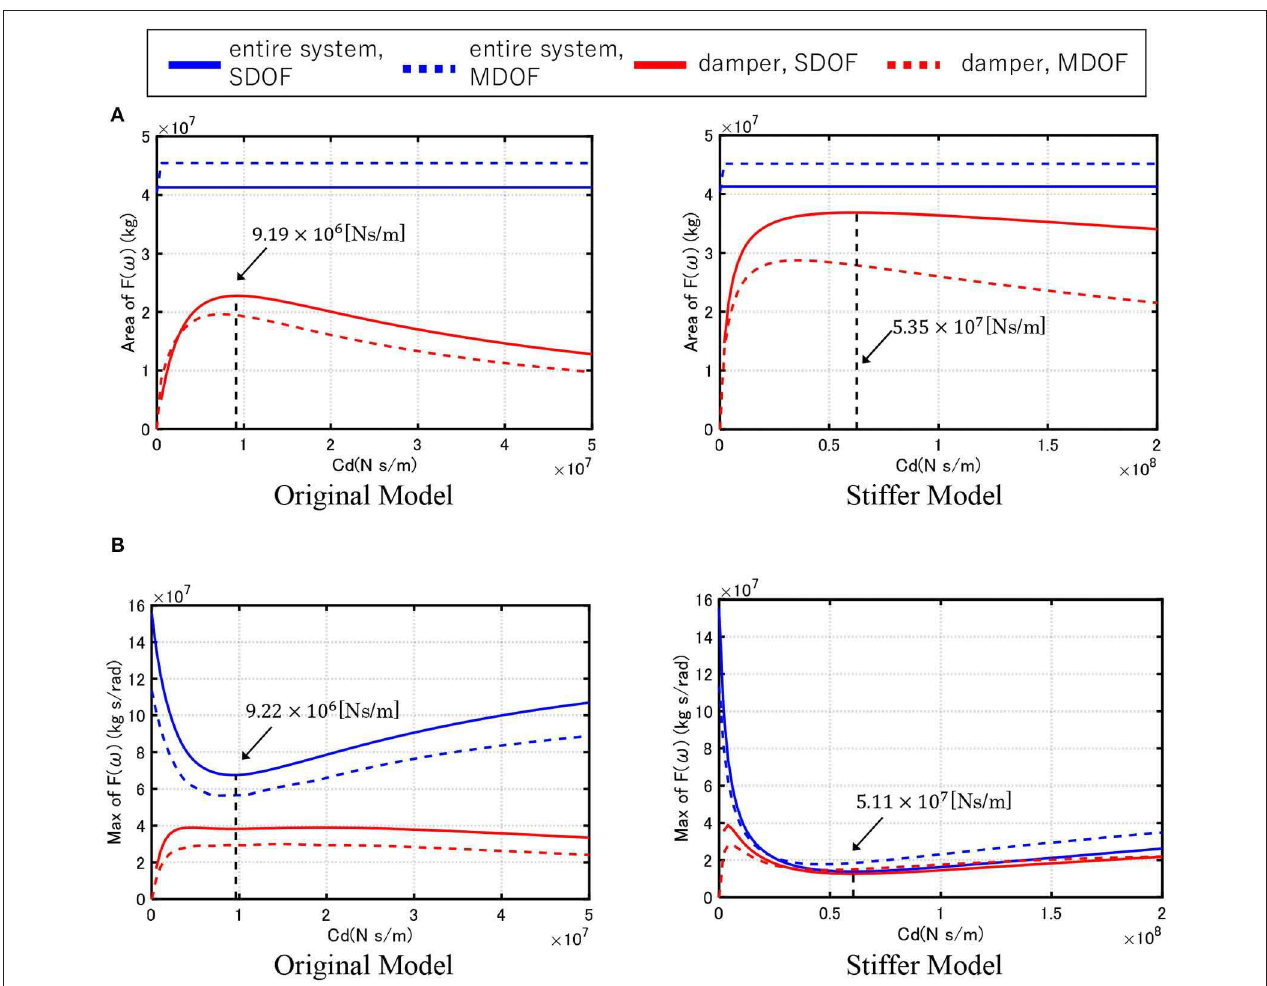
FIGURE 13 | Area and maximum value of energy transfer function with respect to damper level. (A) Area of energy transfer function and (B) Maximum value of energy transfer